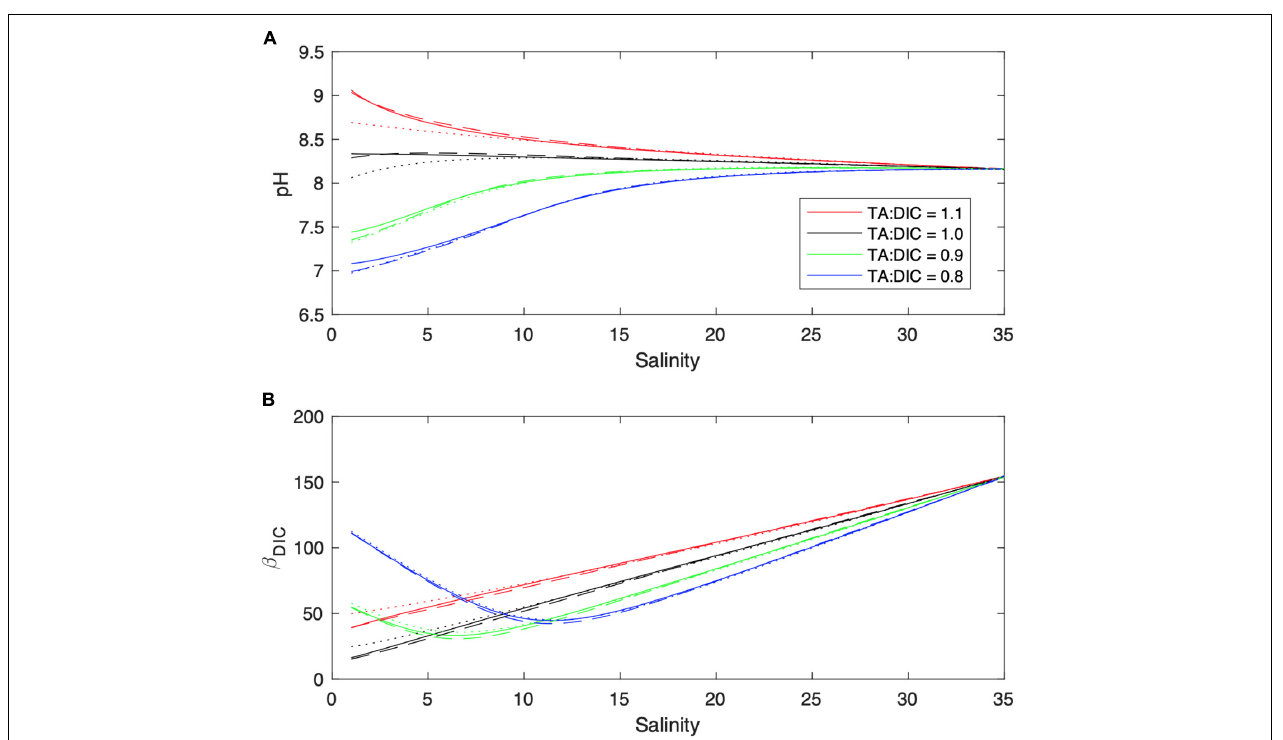
FIGURE 5 | Effect of varying river endmember TA:DIC ratios (1.1 = red, 1.0 = black, 0.9 = green, 0.8 = blue) on pH (A) and β DIC ( B , µ mol kg − 1 ) within the estuary. The dashed lines show the effect of different H 2 CO 3 dissociation constants on calculated pH est [solid line: Millero, 2010 (M10), dash line: Cai and Wang, 1998 (CW98), and dotted line: Lueker et al., 2000 (L00)].